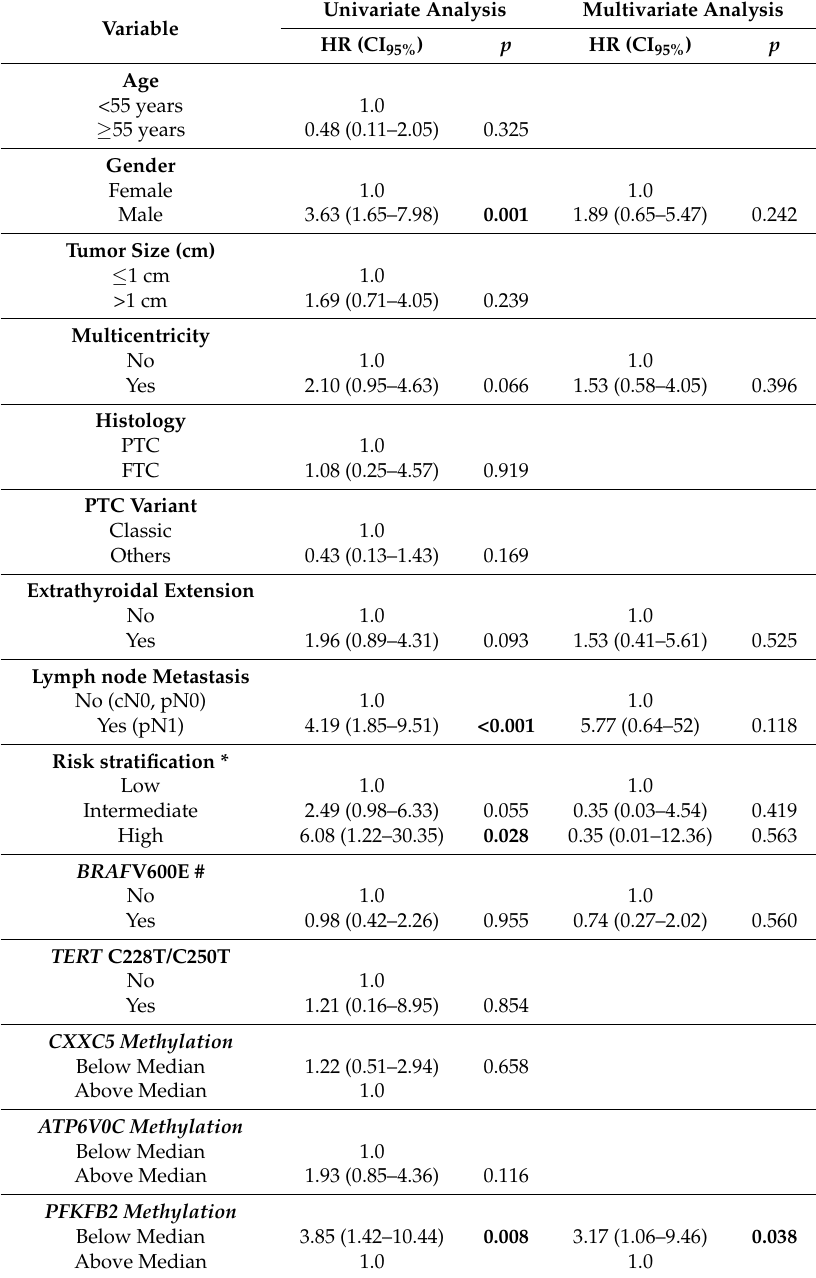
(Figure S4). The multivariate analysis revealed PFKFB2 hypomethylation as an independent factor of high risk of relapse (Hazard Ratio = 3.2; CI 95% = 1.1–9.5) (Table 1). Table 1. Univariate and multivariate analyses of the comparison of clinical, pathological, and molecular characteristics of WDTC samples in relation to the risk of